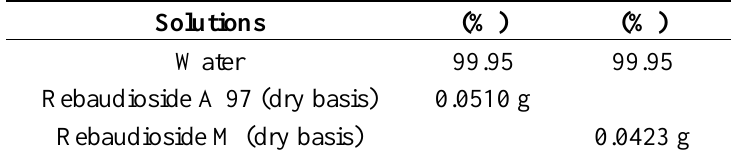
Table 2. Iso-sweet solutions of rebaudioside A ( 1 ) and rebaudioside M ( 7 ) in water.